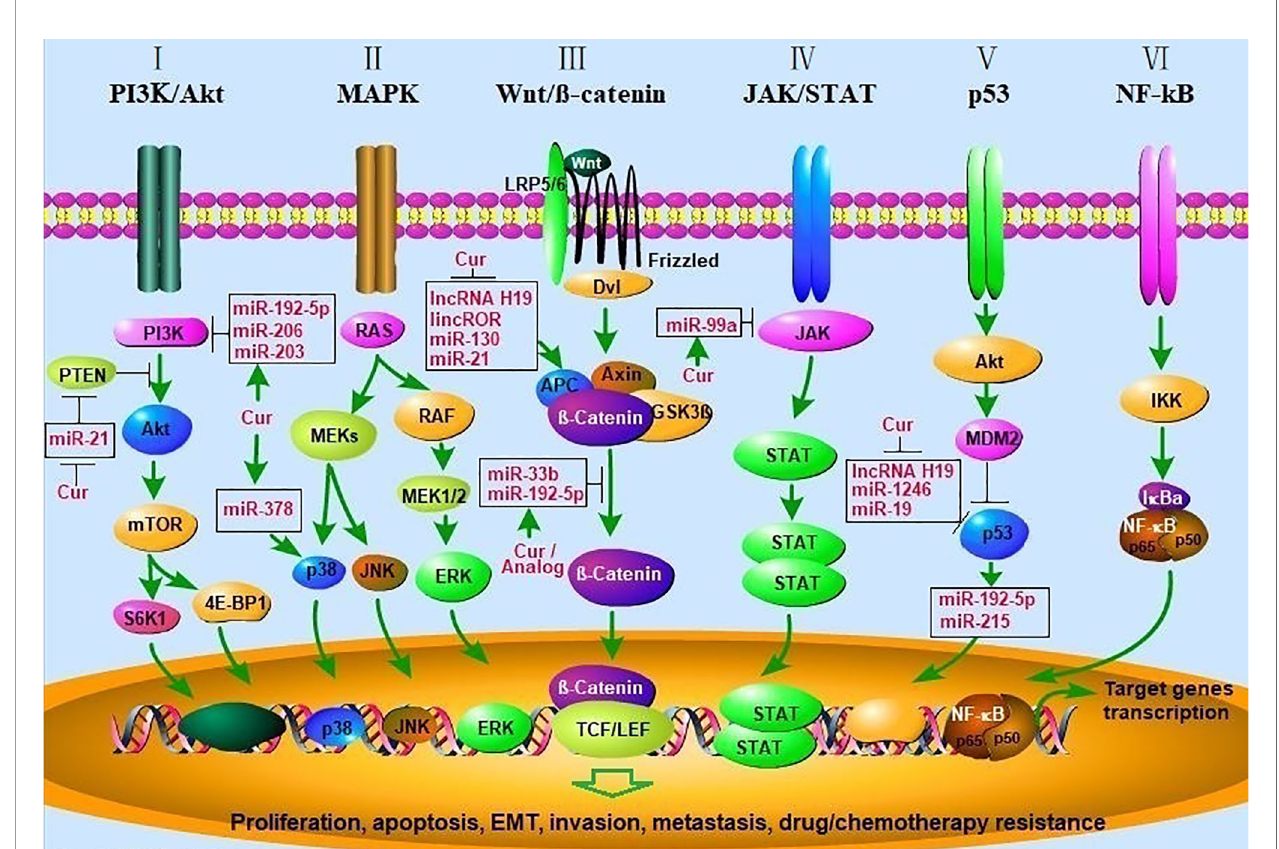
FIGURE 1 | Curcumin modulates cancer progression by regulating multiple signal transduction pathways. (I) Akt/PI3K/mTOR signaling pathway. PTEN inhibits the activation of Akt by PI3K, mTOR phosphorylates p70S6K1 (S6K1) and 4E-BP1 leading to activation of pathways involved in cell growth and survival. Curcumin inhibit the Akt/PI3K/mTOR pathway by enhancing the activity of PTEN via decreasing miR-21 and inhibiting the activity of PI3K via upregulating miR-192-5p, miR-206, miR- 203; (II) MAPK signaling pathway. Signaling cascades leading to activation of the MEKs, which lead to activation of the ERK1/2, p38, and JNK cascades, and then initiate the gene transcription. Curcumin activated p38 MAPK via upregulating miR-378, leading to elevated p21/27, cleaved-caspase-3,9 expression, decreased Bcl-2, MMP2/9 expression. (III) Wnt/ b -catenin pathway. Wnt binds both Frizzled and LRP5/6 receptors to initiate the dissociation of the Axin/APC/GSK3 b complex. b -catenin phosphorylation and then translocates to the nucleus to bind TCF/LEF co-transcription factors, which induces the Wnt-response gene transcription. Curcumin inhibits the Wnt/ b -catenin pathway by inhibiting lncRNA H19, lincROR, miR-130, 21 and upregulating miR-192-5p and miR-33b; (IV) JAK/STAT signaling. The pathway is activated by the binding of a ligand and then convey signals downstream STATs, whereas STATs are transcription factors that activate gene expression; (V) p53 signaling pathway. AKT-induced activation of MDM2, which can inhibit the antitumor activity of p53. Curcumin enhances the anti-tumor activity of p53 by inhibiting lncRNA H19, miR-1246, miR-19; (VI) NF-kB signaling pathway. Signaling cascade leads to the phosphorylation of IkB a resulting in degradation by the proteasome. This releases the NF-kB/p65/p50 complex and allows it to translocate to the nucleus for gene transcription. AKT, v-akt murine thymoma viral oncogene; PI3K, phosphatidylinositol 3-kinase; mTOR, mammalian target of rapamycin; PTEN, phosphatase and tensin homolog; MAPK, mitogen-activated protein kinase; MMP, matrix metalloprotinase), ERKs (extracellular regulated protein kinases), JNK (c-Jun N-terminal kinase; APC, adenomatous polyposis coli; Dvl, Disheveled; GSK3 b , glycogen synthase kinase 3 b ; LRP5/6, low density lipoprotein receptor-related protein 5/6; TCF/LEF, T-cell factor/lymphoid enhancer-binding factor; JAK/STAT, janus kinase/ signal transducers and activators of transcription; MDM2, murine double minute 2; NF- k B, nuclear factor kappa B; IKK, I k B kinase; I k Ba,